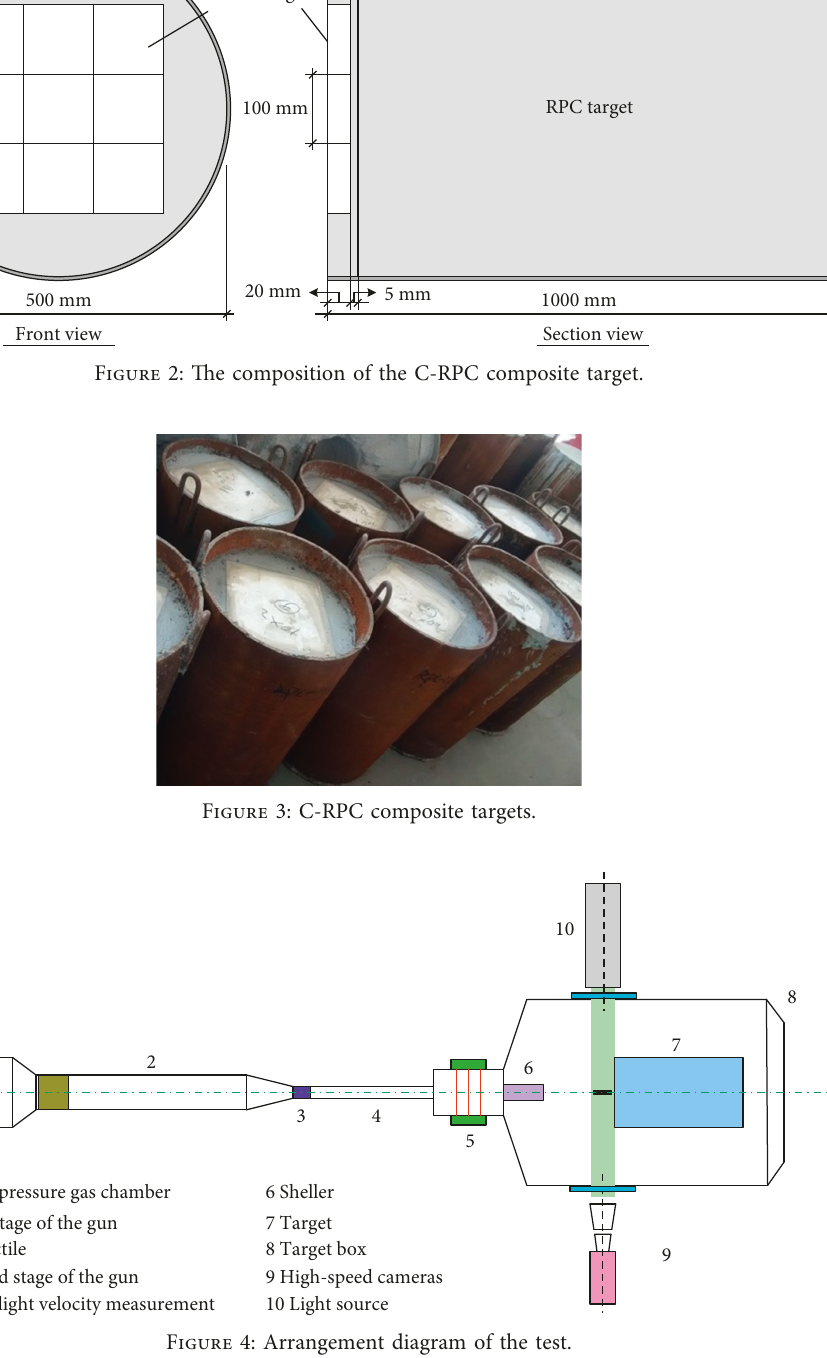
Figure 4: Arrangement diagram of the test.